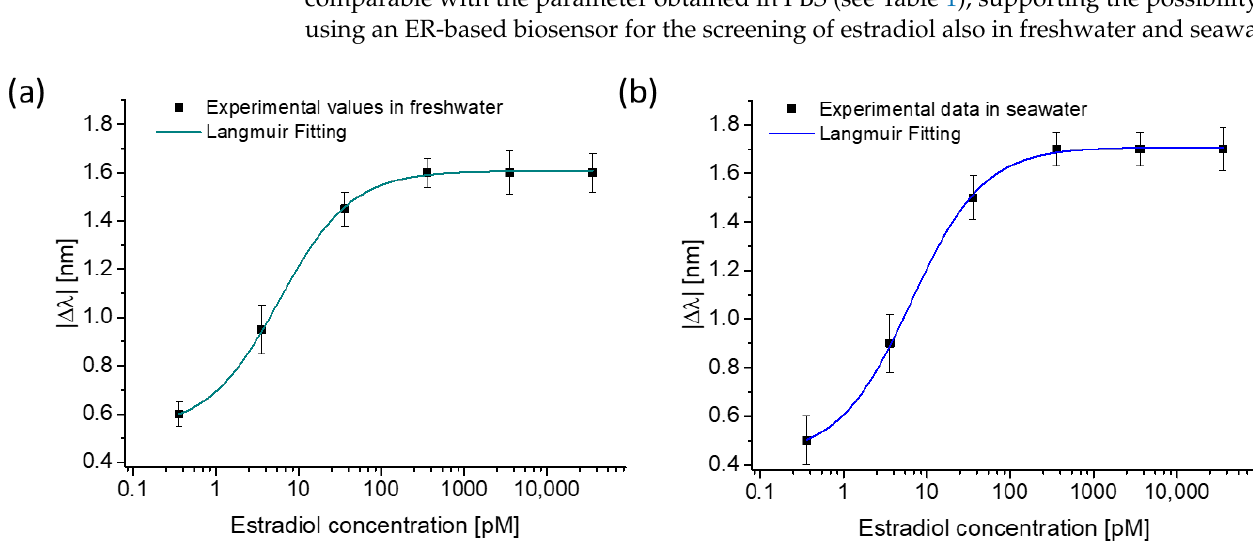
Figure 6. Absolute value of resonance wavelength variation (with respect to the blank) as a function of estradiol concentration on functionalized platform, and Langmuir fitting of the experimental data on a semi-log scale in: ( a ) freshwater, and ( b ) simulated seawater. The error bars were calculated as the standard deviation of the dataset (n = 3). Table 1. Langmuir parameters of estradiol detection in PBS, freshwater, and in simulated seawater.